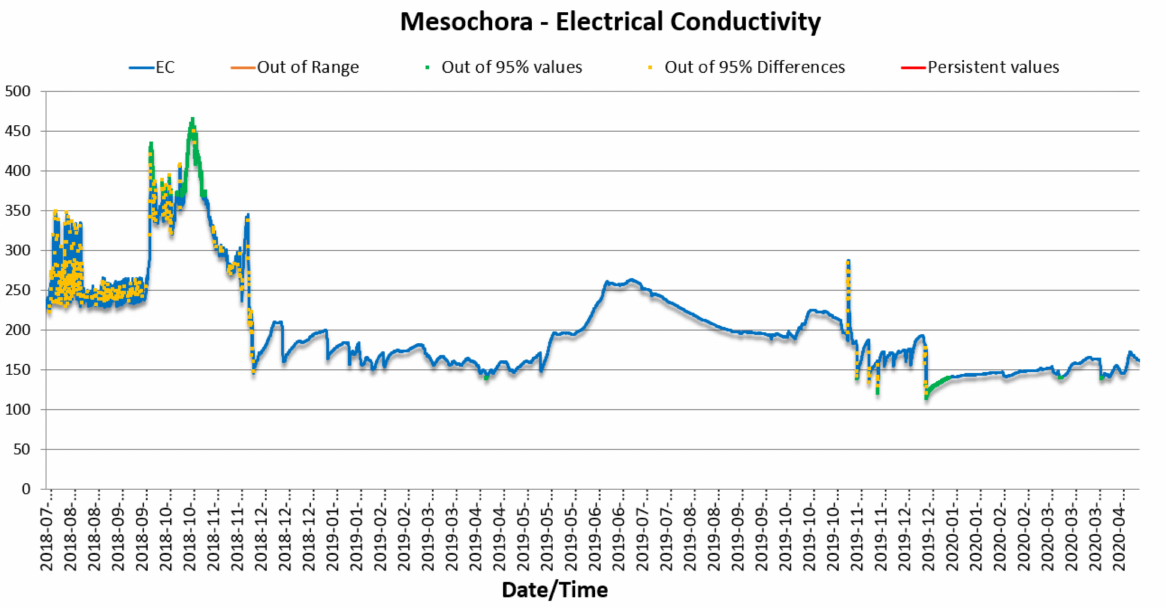
Figure 5. Change of electrical conductivity (EC) (blue line) on an hourly basis at Mesochora station and flagging of values, which are outside the 2.5% and 97.5% percentiles of observations (green color) and outside the 2.5% and 97.5% percentiles of absolute differences of consecutive observations (yellow color). No out of allowable range EC values (orange color) or unchangeable EC values for more than two days of continuous recording (red color) have been